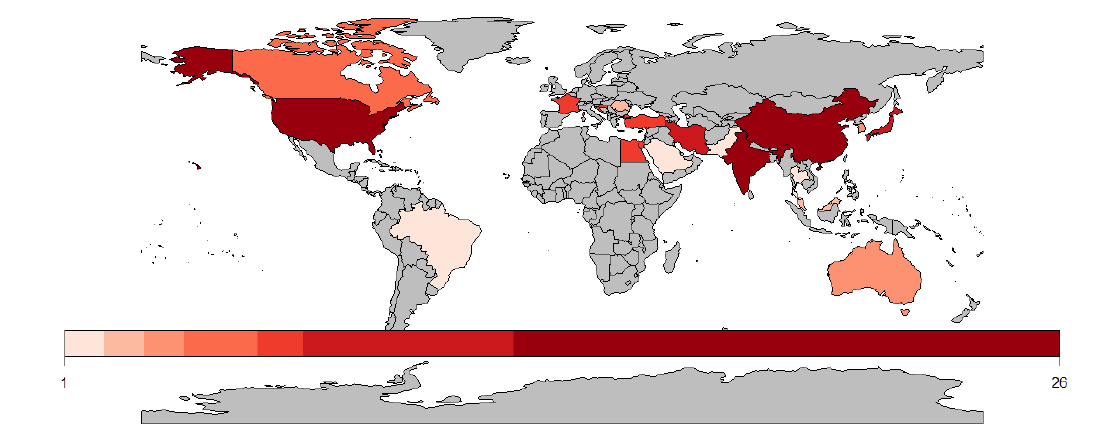
Figure 5. Distribution of researchers around the world.